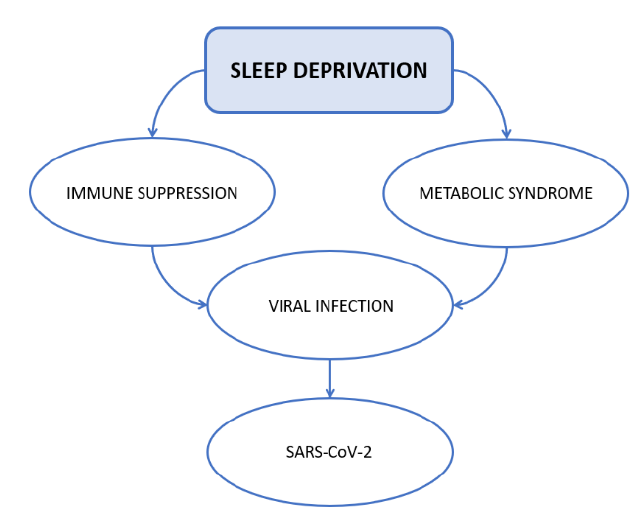
Figure 1. Possible mechanisms of interaction between sleep deprivation and increased risk of SARS-CoV-2 infection.